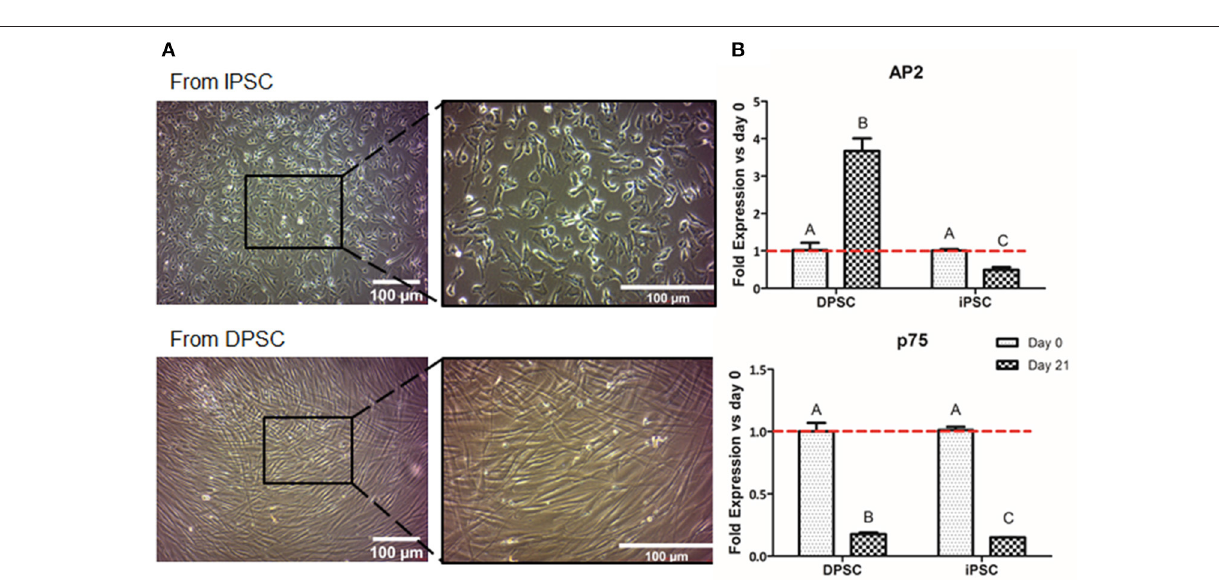
FIGURE 3 | Formation of NCSC using an adherent method. Microscope images of NCSC-derived from iPSC and from DPSC at day 21 of differentiation (A) . Relative mRNA expression in NCSC-derived from DPSC and iPSC, at days 0 and 21, analyzed by quantitative RT-PCR (B) . *Scale bar: 100 µ m. **Data presented are means ± SD, n = 3 technical replicates per experimental group. Different letter denotes significant differences ( p < 0.05). Same letter denotes non-significant